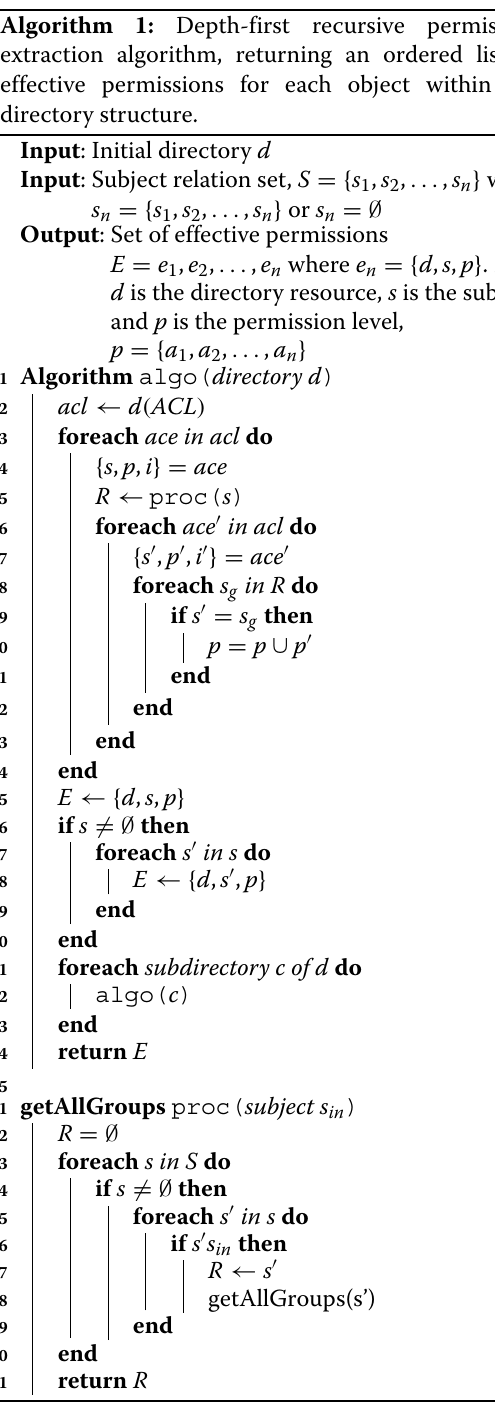
Algorithm 1: Depth-first recursive permission extraction algorithm, returning an ordered list